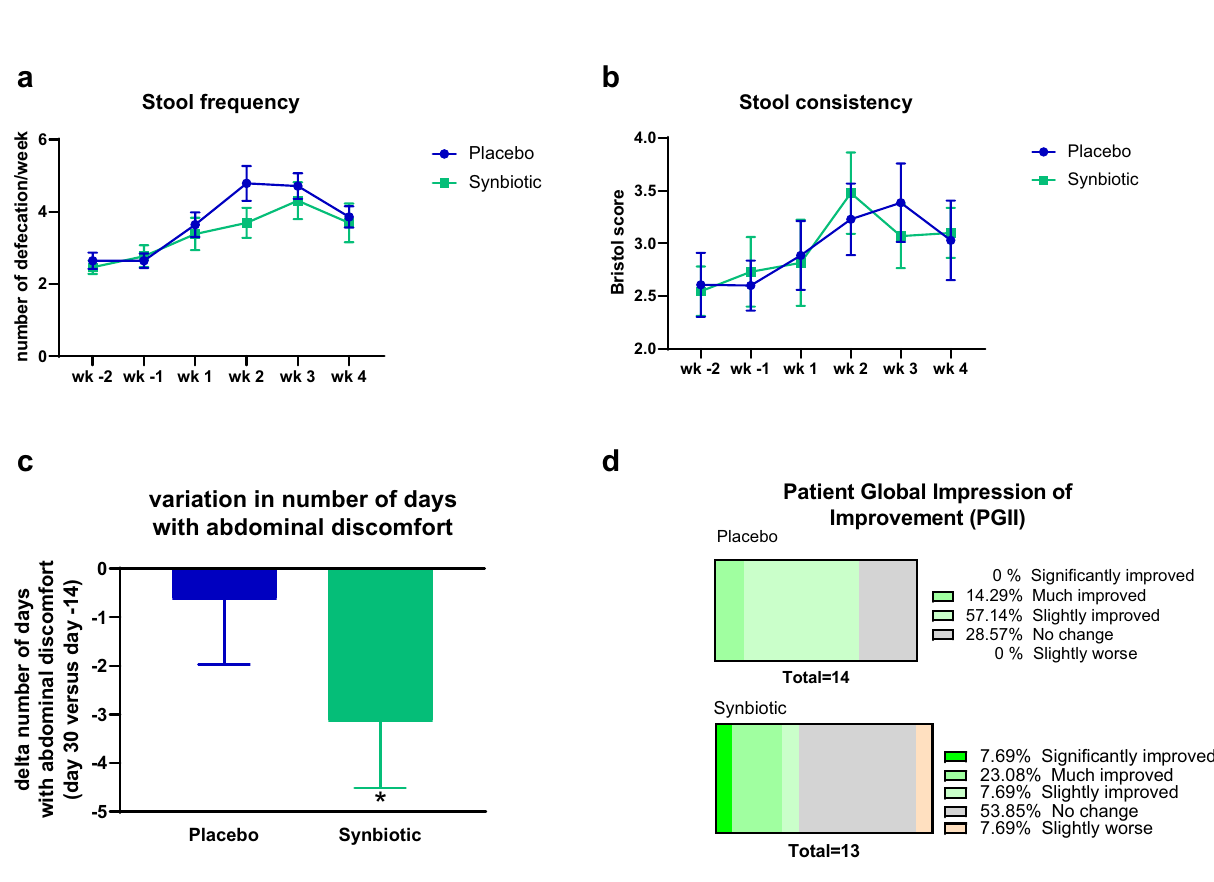
Figure 1. Transit characteristics in middle-aged adults receiving placebo or synbiotic for 30 days. Values are means ± SEM except for d (placebo: n = 14, synbiotic: n = 13). Mixed model ANOVA were performed to compare evolution of stool frequency and consistency (time effect: *p < 0.05). Matched-pairs Wilcoxon signed-rank test was performed for the number of days with abdominal discomfort to compare changes from baseline (*p < 0.05). wk week (wk-2: d-13 to d-7; wk -1: d-6 to d0; wk 1: d1 to d7; wk 2: d8 to d14; wk 3: d15 to d21; wk 4: d22 to